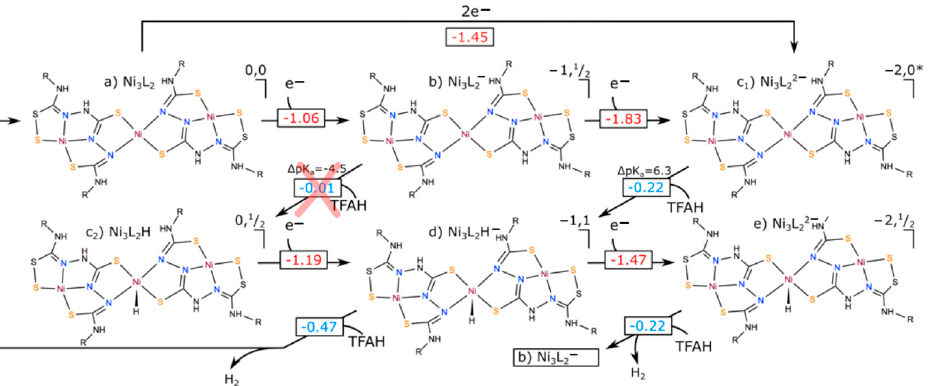
Figure 9. Different catalytic cycles that could be performed by Ni 3 L 2 . Numbers in red correspond to redox potentials (in V), whereas those in blue are free energy differences for proton transfer events, in eV. ∆ pK a displayed for the first proton transfer event corresponds to the difference in pK a s between Ni 3 L 2 H and TFAH. The red cross indicates that the ECEC path is thermodynamically unfavourable due to a higher pK a of TFAH compared to the catalyst. Note that an EECEC mechanism would cycle back to point (b) once H 2 is formed, since two electrons and two protons would be gone, leaving one unpaired electron in the complex.